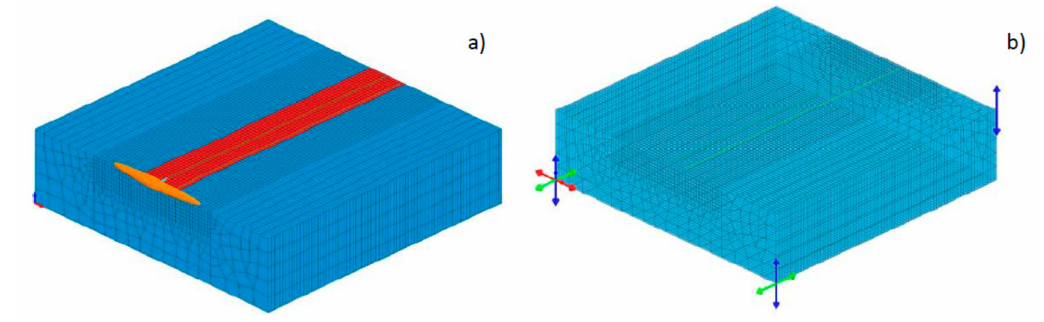
Figure 23. View ( a ) of a three-dimensional model of the bead-on-plate laser welding process performed on 6.0-mm steel samples using a high-power diode laser together with a double-ellipsoid heat source model and the loaded area (red color), and ( b ) clamping conditions.